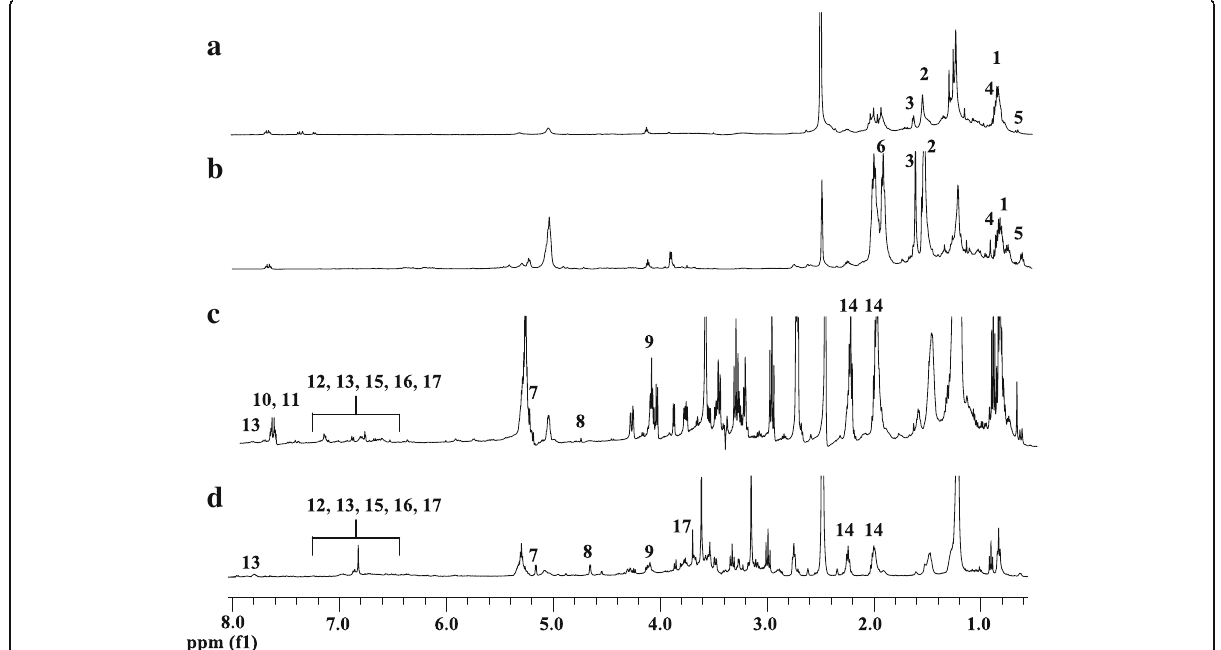
Fig. 1 The representative 1 H NMR spectra of HF ( a ), CF ( b ), EF ( c ) and MF ( d ) of N. oleracea . 1, fatty acids; 2, alanine; 3, leucine; 4, valine; 5, oleanolic acid; 6, phytosterol; 7, α -glucose; 8, β -glucose; 9, fructose; 10, quercetin derivatives; 11, kaempferol derivatives; 12, myricetin derivatives; 13, apigenin derivatives; 14, catechin; 15, gallic acid; 16, 3,4- O -dimethylgallic acid; 17, caffeic acid